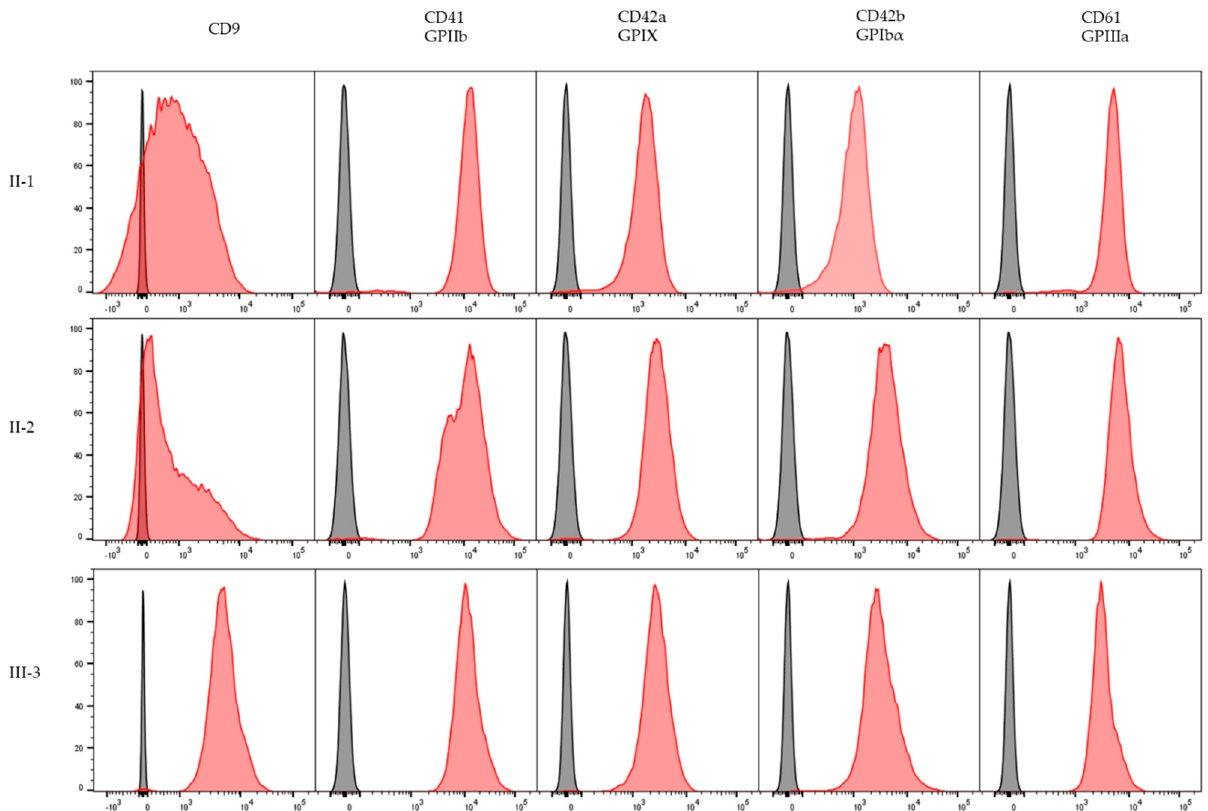
Figure 2. Platelet immunophenotype. CD41, CD61, CD42a, CD42b, CD9 antigens expression and negative controls on the platelets of two thrombocytopenic patients (II-1, II-2) and one healthy individual (III-3). Flow cytometric analysis shows decreased expression of the GPIb α -IX complex and CD9 and slightly increased expression of GPIIb and GPIIIa in both patients compared to the healthy individual. Negative controls are in grey, population of interest is in red. The peak height is normalized to mode.